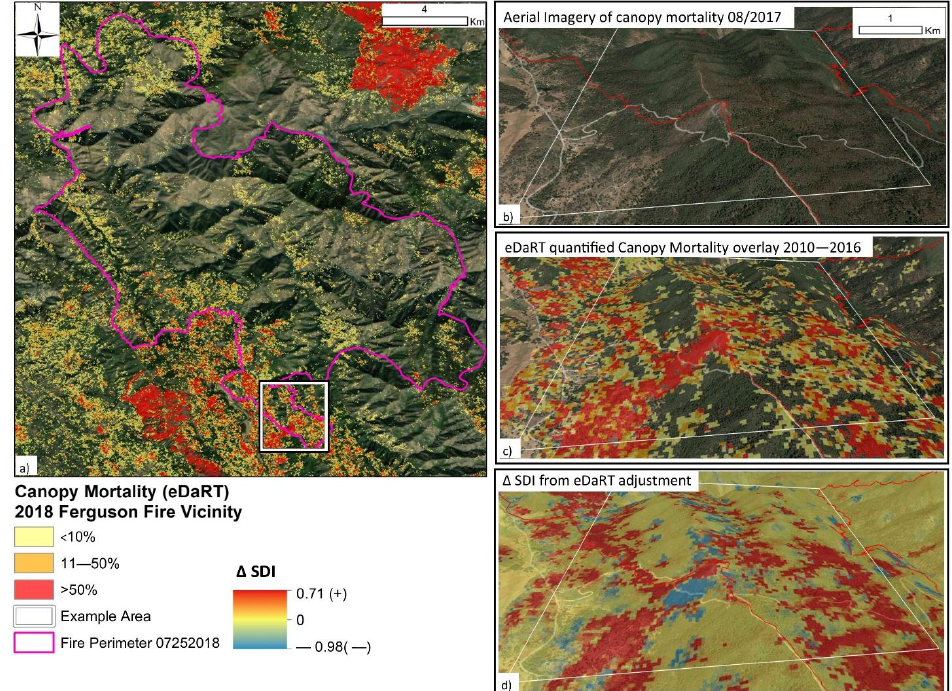
Figure 5. Mapped canopy mortality used to inform fire responders of snag hazard on the 2018 Ferguson Fire, Mendocino National Forest, CA. A general overview of snag hazard concerns in the vicinity of the actively growing fire ( a ) was informed by aerial imagery ( b ) and remote sensing products ( c ). Snag hazard was used to alter surface fuel models and spread direction assumptions in SDI calculations and demonstrated increased SDI values in most areas of high canopy mortality ( d ). Canopy mortality estimates leveraged the ecosystem disturbance and recovery tracker system (eDaRT) under development at the regional remote-sensing laboratory.